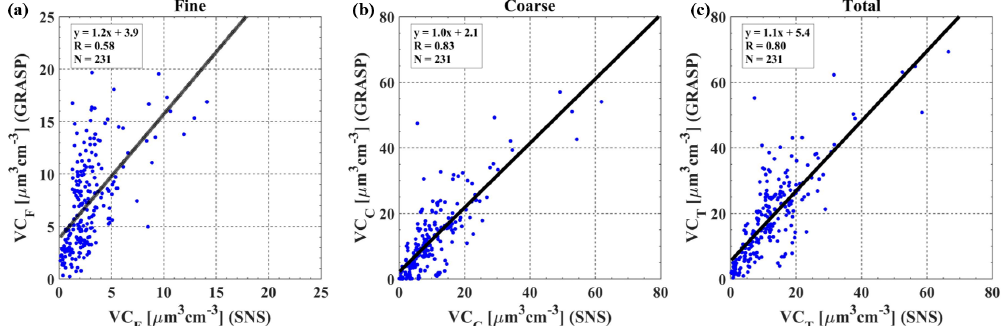
Figure 2. Volume concentration (VC) retrieved by GRASP at the SNS height versus in situ measurements at the SNS for (a) fine, (b) coarse, and (c) total modes.